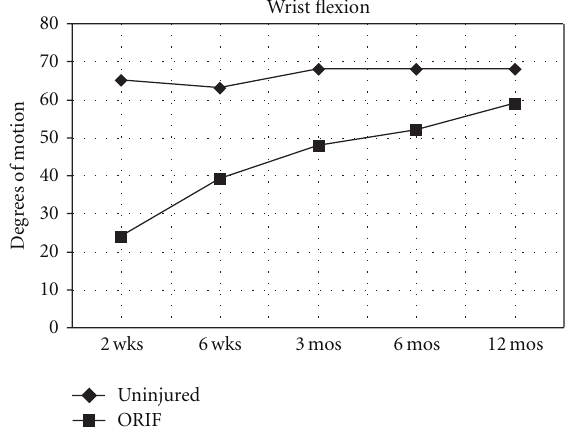
Figure 2: Mean wrist flexion measured in degrees at follow-up clinical visits for noninjured wrist and for wrist with an unstable fracture of the distal radius treated with open reduction and internal fixation with a volar fixed-angled